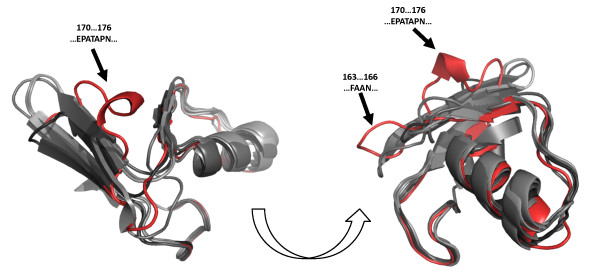
Visual alignment of the linker region between NDM-1 and other B1 MBLs. NDM-1 is shown in red, against varying shades of gray for IMP-1, ccrA, VIM-2 and BlaB. N- and C-terminal regions align well across all B1 MBLs, but for NDM-1 the center of the linker region is distal, indicated by arrows and labeled by their positioning and residues within NDM-1. The shown structures correspond to 120-166 in ccrA, 98-143 in IMP-1, 138-200 in VIM-2, 138-200 in BcII and 141-193 in NDM-1; these ranges include N- and C-terminal anchor sequences that flank the linker region and are generally well conserved. Graphics were generated using PyMol [39].